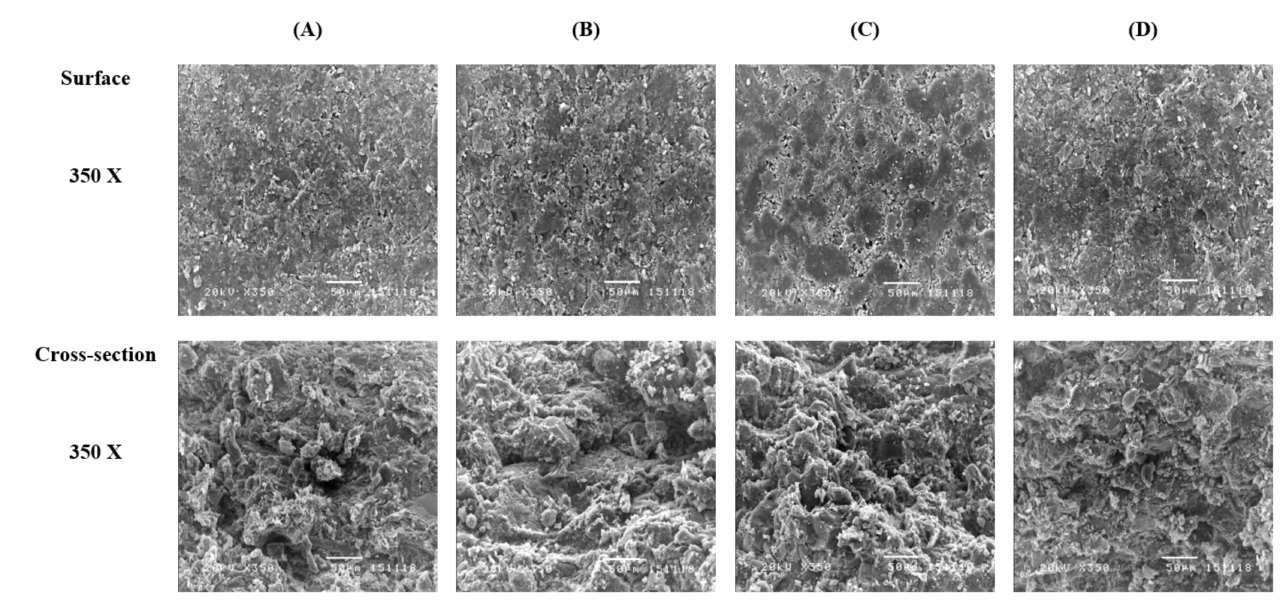
Figure 5. SEM images of Tab-K4M ( A ), Tab-K15M ( B ), Tab-K100M ( C ), and Tab-Mixed ( D